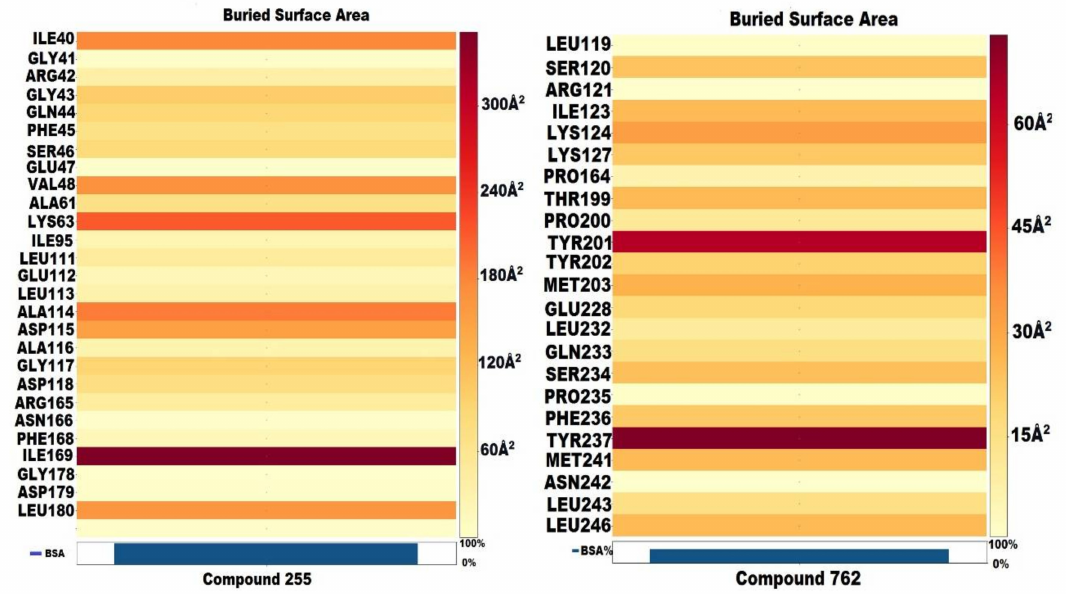
Figure 10. Buried surface area (BSA) of compound 255 and 762